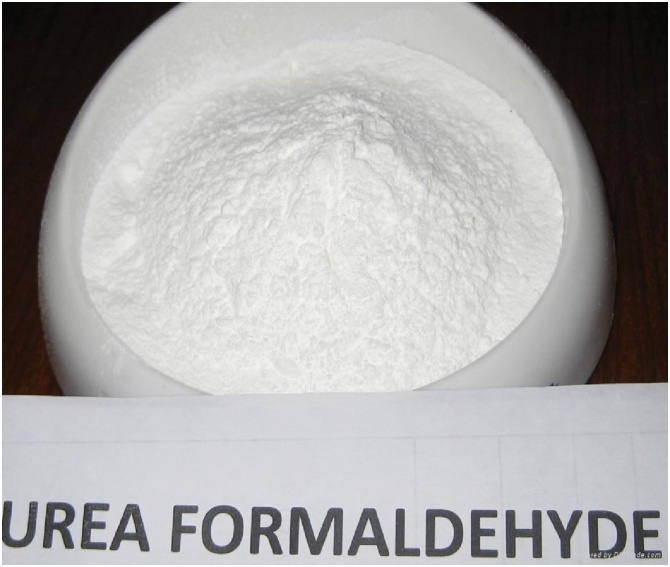
Urea Formaldehyde.